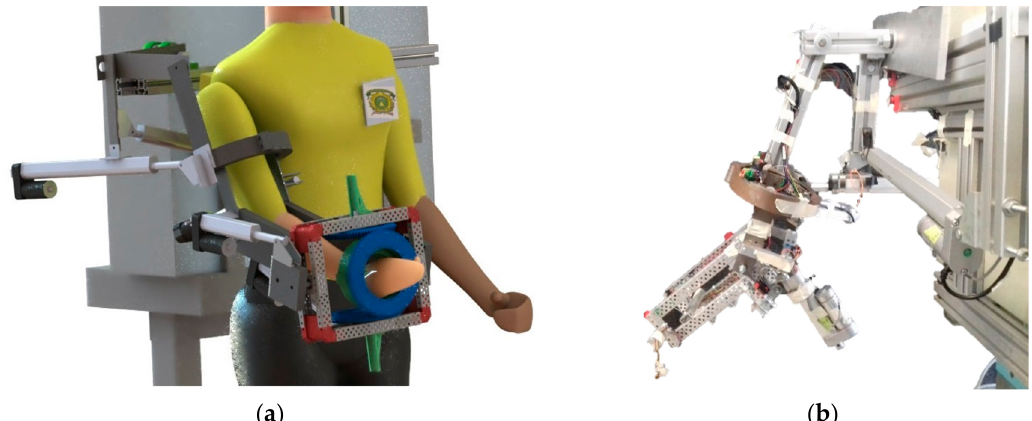
Figure 1. ( a ) CAD model of the ERMIS exoskeleton and ( b ) EPM of the ERMIS. Table 1. Ranges of motion of the ERMIS exoskeleton. Movement Range of Motion ( ◦ ) Shoulder adduction-abduction 0 to 164 Shoulder flexion–extension 0 to